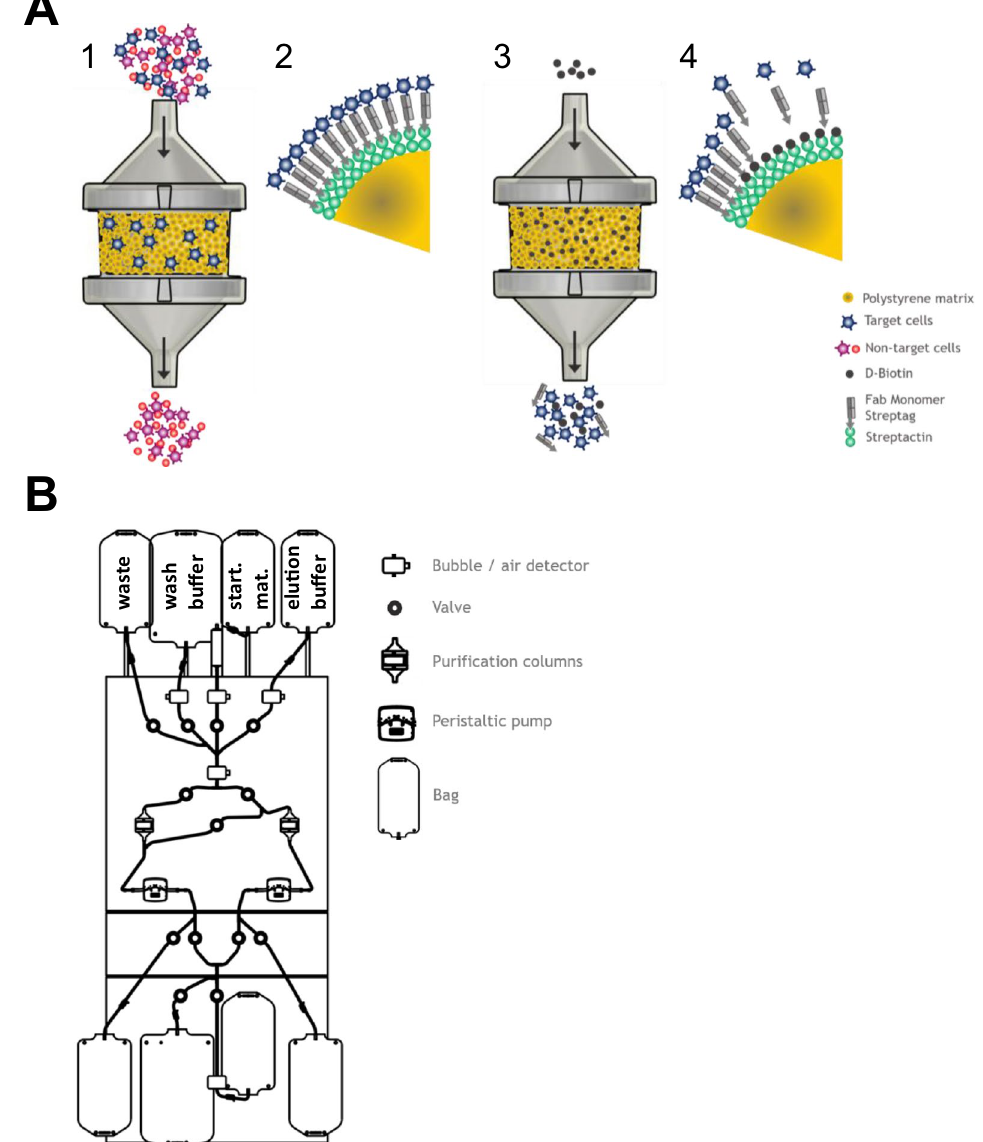
Figure 1. Schematic depiction of automatic column-based selection of target cells using cell affinity chromatography. ( A ) Target cell selection procedure: Starting material is loaded onto the bead-filled column (1) enabling binding of target cells to the specific Fab fragments on the bead surface and flushing out the non-target cells (2). Elution of pure target cells from the column is executed by adding D-biotin buffer (3). Biotin replaces the Fab in the Strep-tag binding pocket and therefore target cells are released and collected (4). ( B ) Schematic drawing of ATC hardware selection device’s front plate with selection tubing set. The device consists of valves for controlling the liquid flow path, peristaltic pumps for transporting liquids, bubble detectors for recording air in the system and column holders with shaking function. The tubing set is a dry, sterile and ready-to-use tubing set for target cell purification and contains two separate columns including pre-mounted empty bags for collecting different cell fractions as well as bags for wash buffer, D-biotin elution buffer and apheresis starting material (as